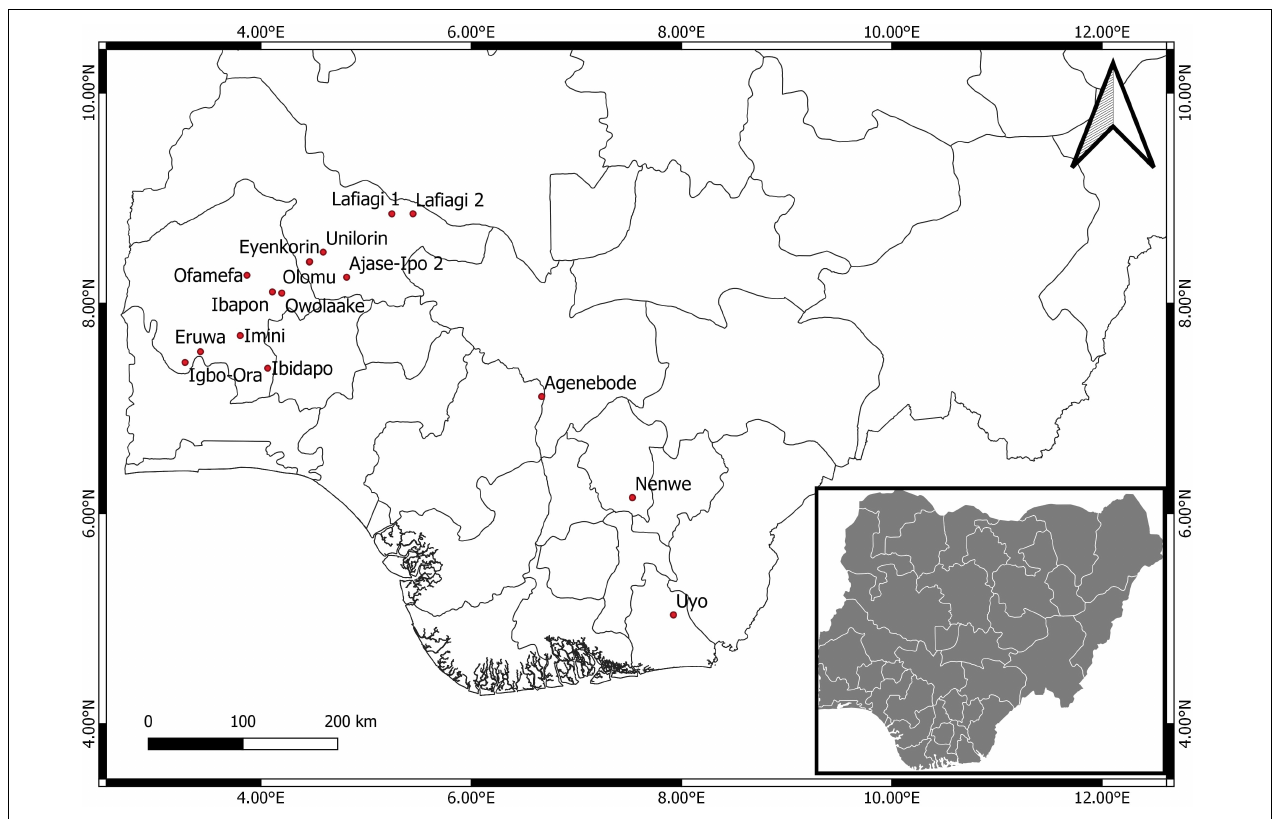
FIGURE 1 | Map of Nigeria showing the areas sampled for CMV symptoms in this